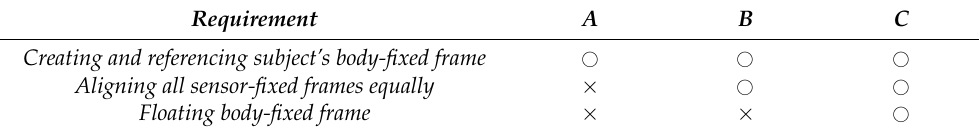
Table 1. Classification of the motion recognition method according to the requirement satisfaction. Requirement A B C Creating and referencing subject’s body-fixed